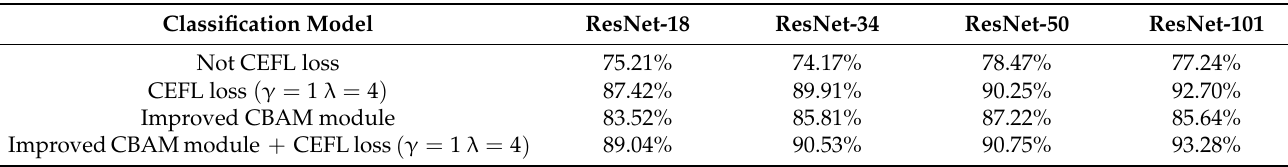
Table 10. Accuracy rates for each classification model.